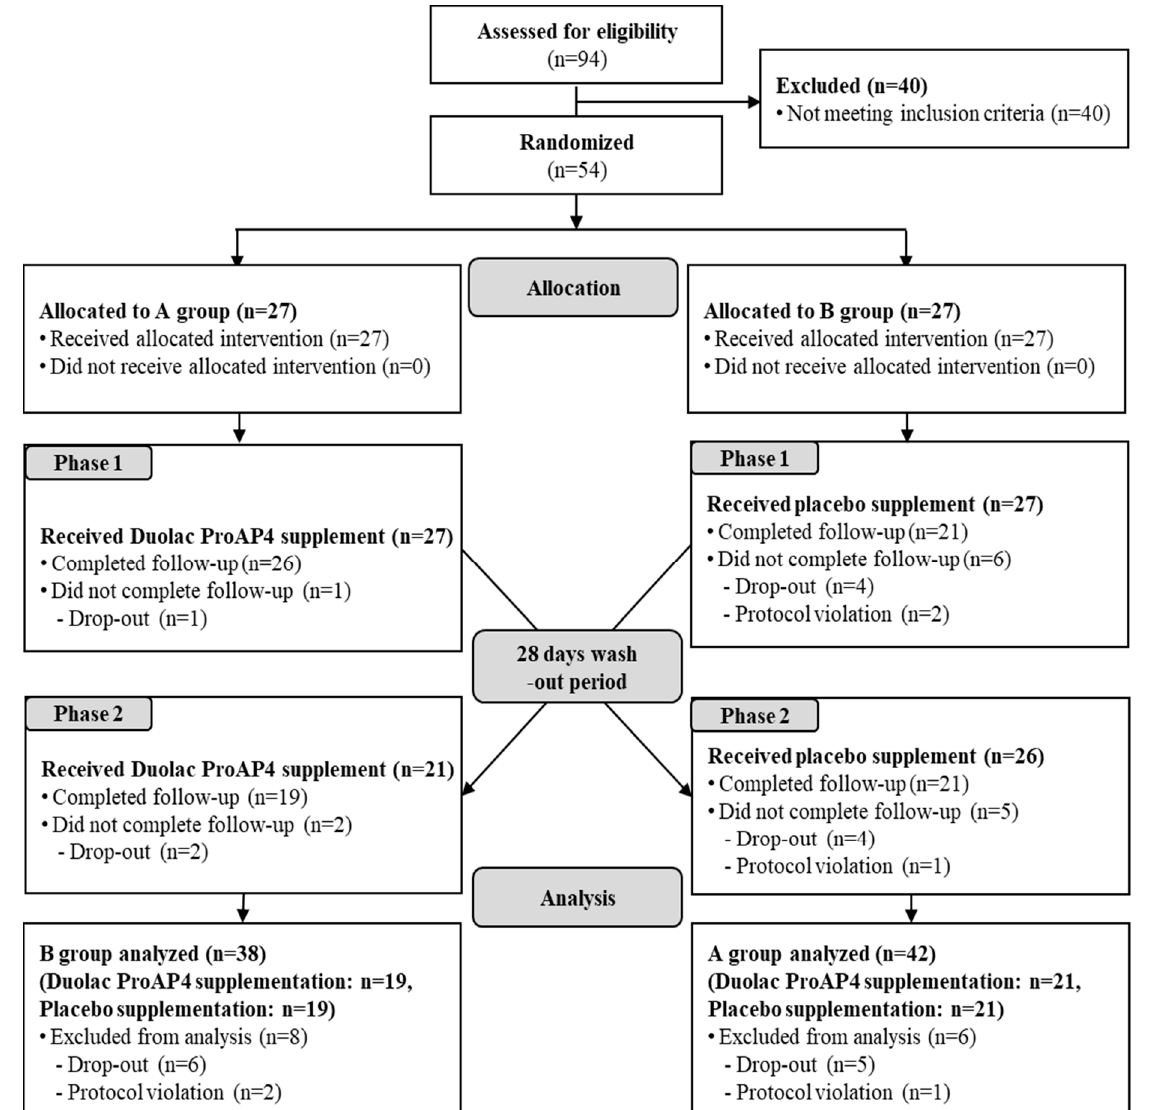
Figure 2. Flow diagram showing the selection and allocation of participants in the investigation. Table 1. Demographic characteristics of the study subjects.